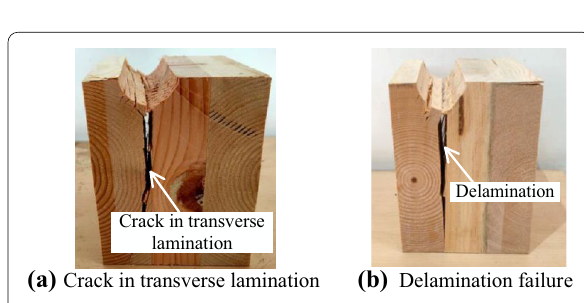
Fig. 8 Specimen with dowel positioned between layer ( θ of 90 degree)